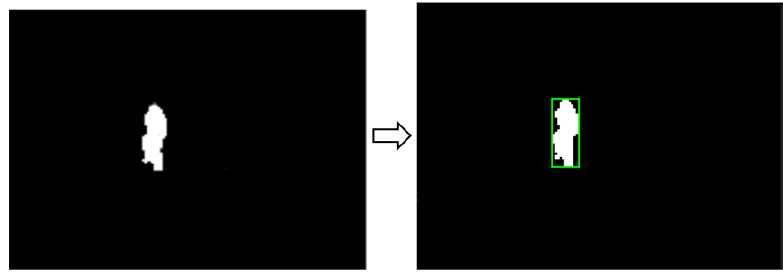
Figure 18. Image detection — segmentation.